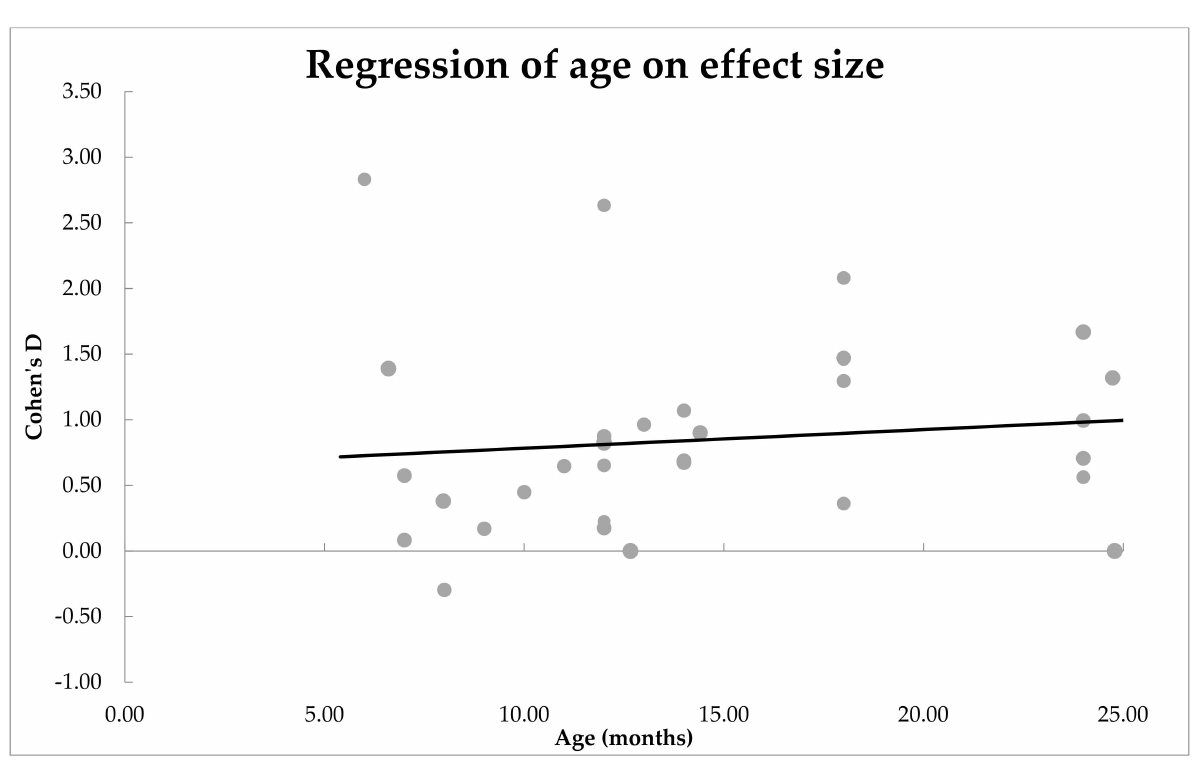
Figure 5. Scatterplot of how age moderated the mean difference between ASD and non-ASD infants’ receptive vocabulary. No significant effect of moderator was